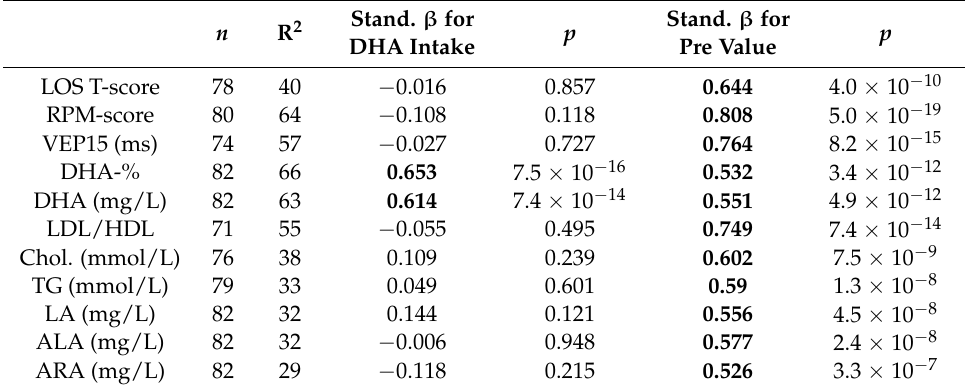
Table 2. Association between study DHA intake and pre intervention values with the post intervention status of fatty acids and functional outcomes; outcomes were regressed on DHA intake and corresponding pre study value, R 2 corresponds to the percentage of outcome variance explained by the regressors (DHA intake and pre value), significant associations ( p < 0.01) are printed in bold. Stand. β for Stand. β for n R 2 p DHA Intake